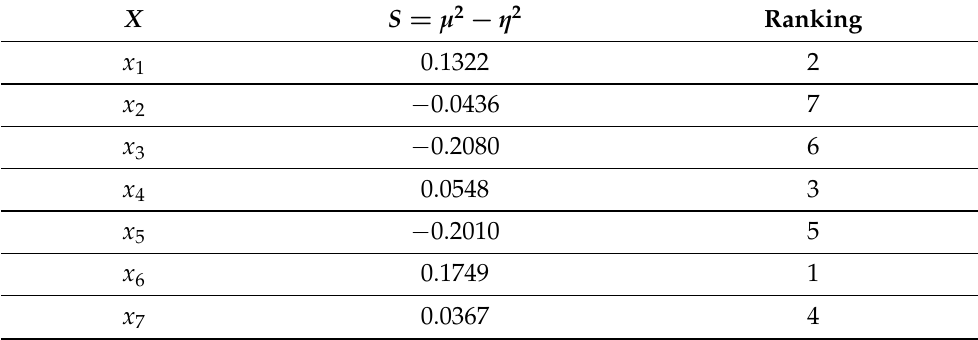
Table 4. Score function values of alternatives.